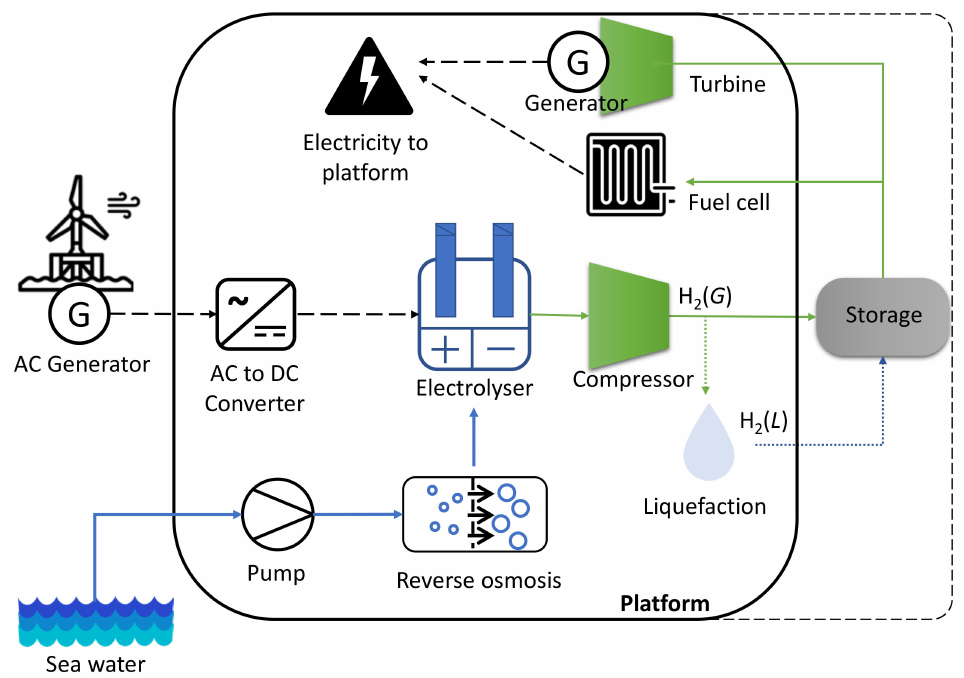
Figure 4. Schematic of offshore hydrogen production from wind. For hydrogen compression, the dimensions of a non-lubricated piston compressor for hydrogen service were considered [51], yielding a footprint density of 81.4 MWh/m 2 . Further electrification via a hydrogen gas turbine, as used in the Enel’s hydrogen demon- stration at Fusina [52], yields a footprint density of 0.36 MW/m 2 . As per the footprint of the different hydrogen storage solutions, for the sake of consis- tency, a Length/Diameter ratio of 5 was considered [53], assuming compressed gas stored at 300 barg and 20 ◦ C yields a footprint density of 8.5 MWh/m 2 . The storage of hydrogen in metal hydrides occupies up to 18 times smaller volumes than the equivalent gas storage in vessel tanks (at 40 barg and 20 ◦ C) [54], yielding a footprint density of 1.6 MWh/m 2 . For liquid hydrogen at 2 barg and − 250 ◦ C, the same container dimensions yield a footprint density of 27.5 MWh/m 2 . However, adding a liquefaction plant to the platform premises increases the technology